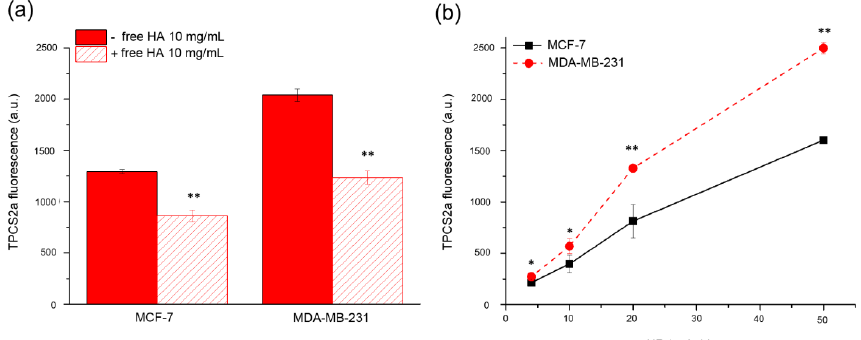
Figure 1. CD44-mediated endocytosis of HA@TPCS 2a -NPs. ( a ) Uptake of HA@TPCS 2a -NPs (50 μg/mL NPs) in MDA-MB-231 and MCF-7 cells after 2 h of incubation at 37 °C in medium with or without 10 mg/mL of free HA. ( b ) Concentration-dependent uptake of HA@TPCS 2a -NPs in MDA-MB-231 and